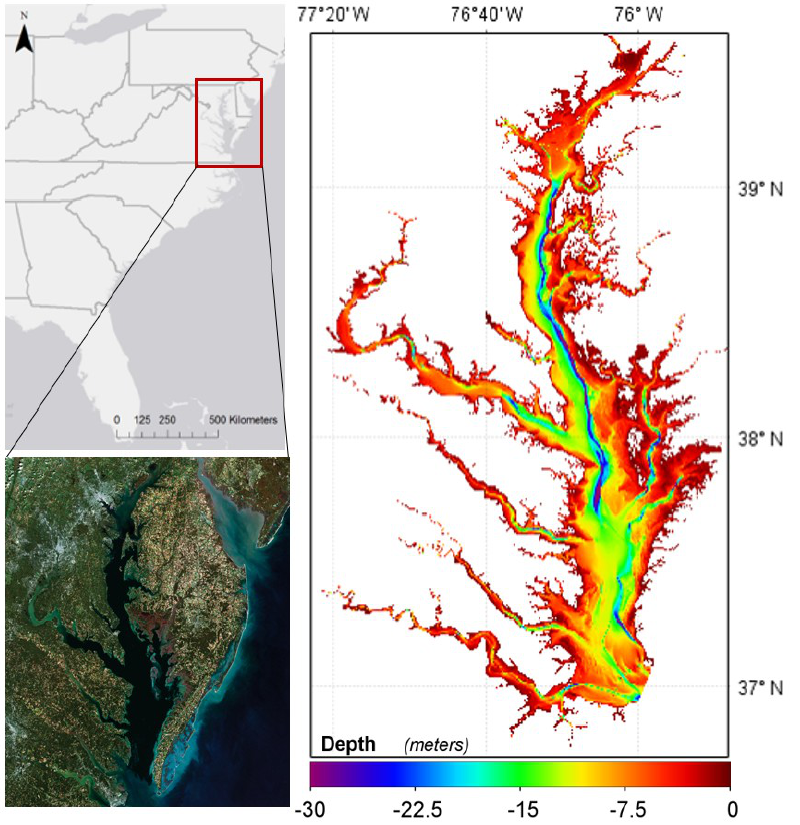
Figure 1. Map showing the location and bathymetry of Chesapeake Bay.